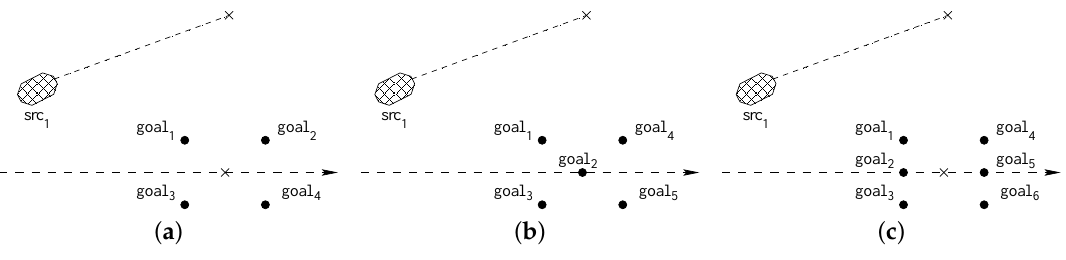
Figure 13. A graphical representation for the D points selected by kernel DRAW S AMPLE K ERNEL based on our splitting policy. The initial direction of the car must be modified to converge toward D = 4 ( a ), D = 5 ( b ), or D = 6 ( c ) different goals, respectively. The picture shows how goals are selected based on the initial curve projection on the desired